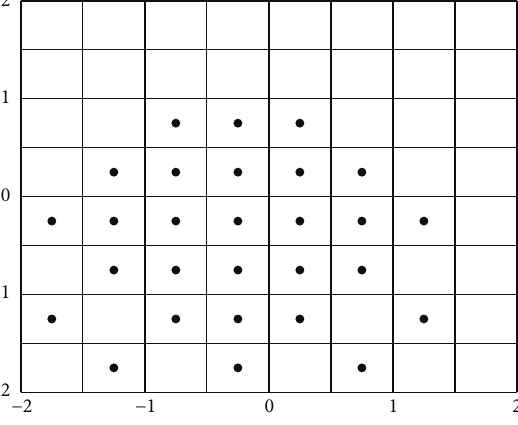
Figure 6: Array configuration for 66 elements.